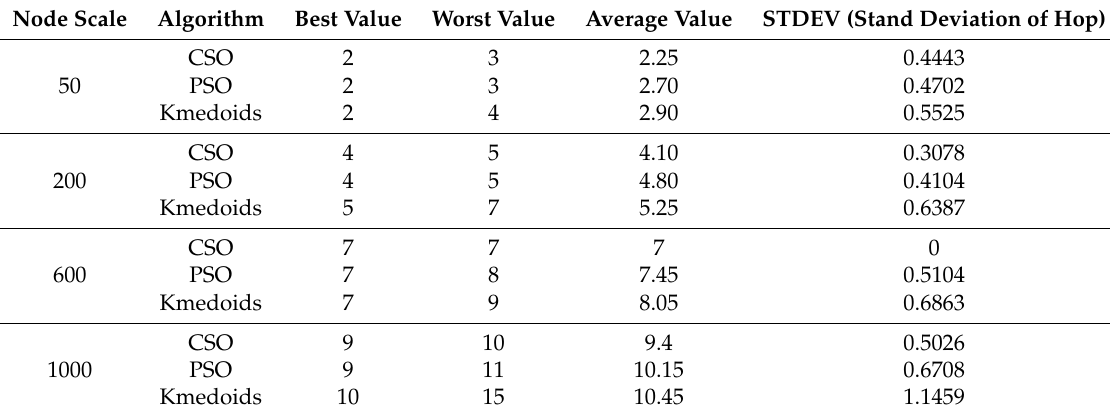
Table 1. Coverage radius of three algorithms at different node